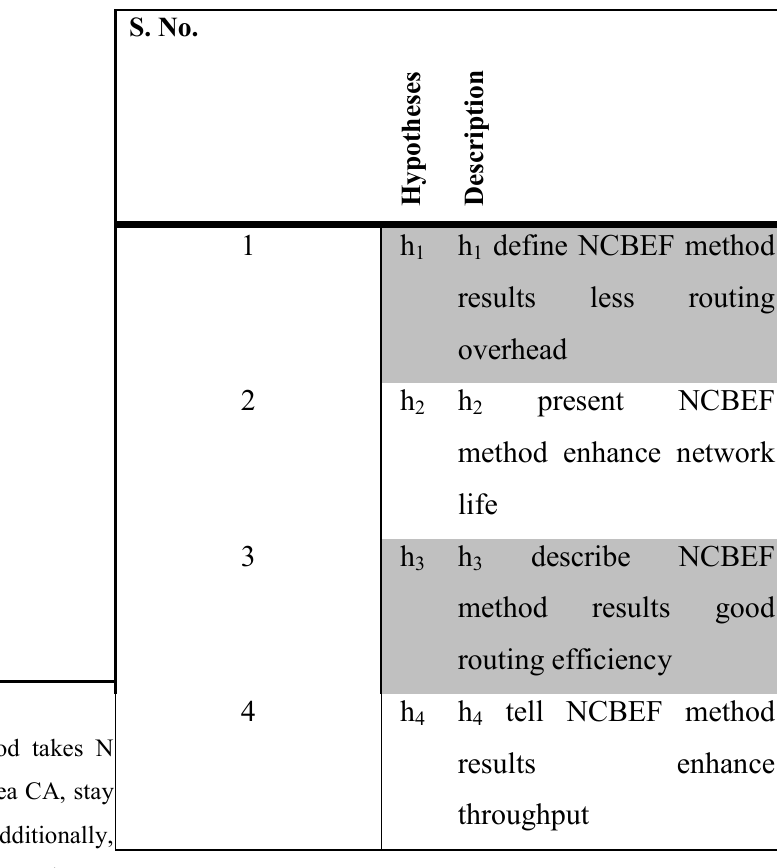
Table 1. Formulated